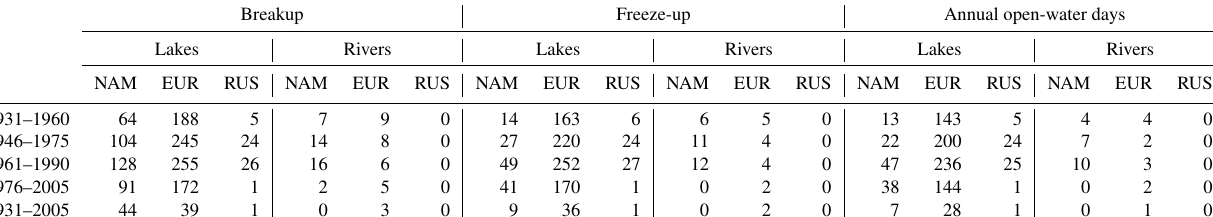
Table 2. Summary of the number of sites with at least 90% of annual data available for breakup, freeze-up, or annual open-water days across the five time periods and geographical regions. NAM, EUR, and RUS are abbreviations for North America, Europe, and Russia, respectively.